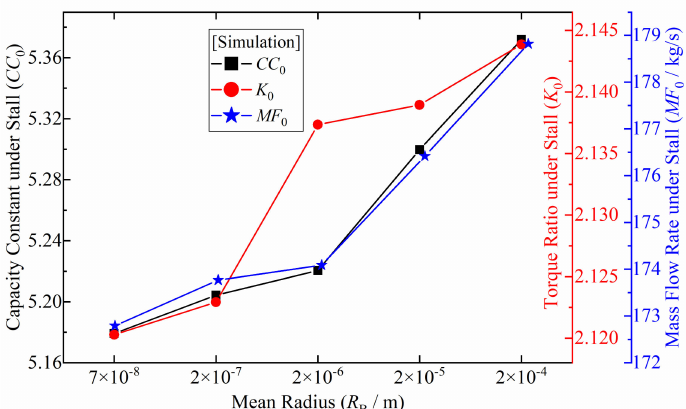
Figure 25. The capacity constant, torque ratio and mass flow rate of torque converter at stall under various mean radius.